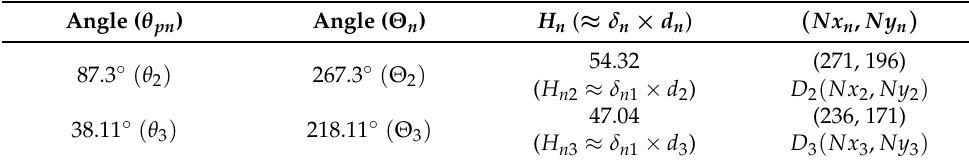
Table 7. Localization of drones 2 and 3 in master drone image.